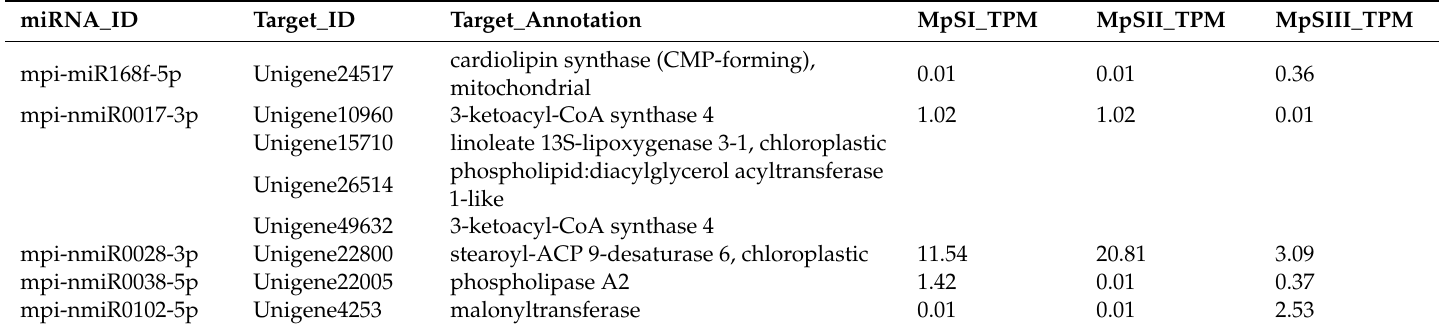
Table 4. Pongamia miRNAs with putative targets in relation to lipid